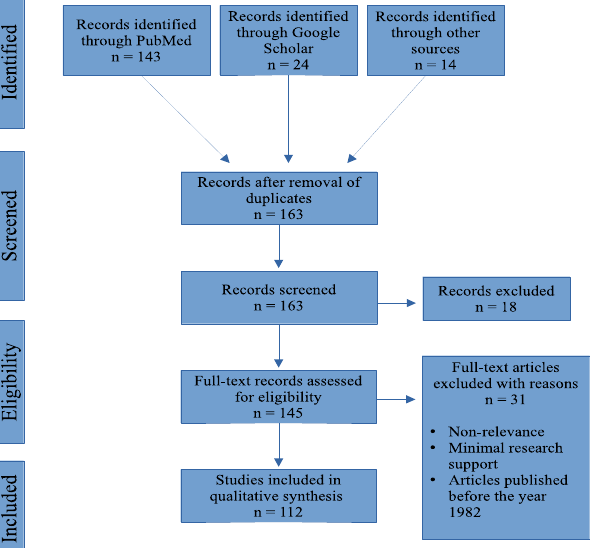
Figure 1. Flow chart outlining the number of articles accessed from online biomedical